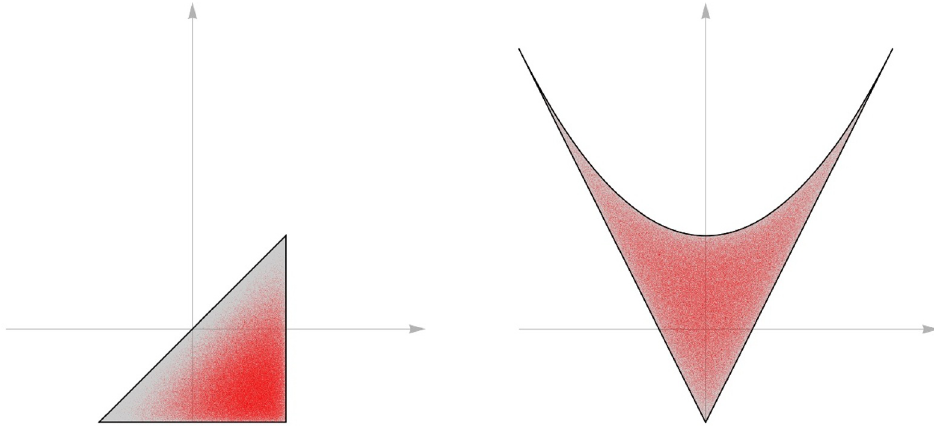
Figure 21 . A cumulative plot for the 75 primes p 428 (cid:20) p (cid:20) p 502 showing how the ( a; b )-points lie in ~ S and how the preimages of these points lie in ~ S 0 . Note how the frequency declines near the diagonal boundary of ~ S 0 .